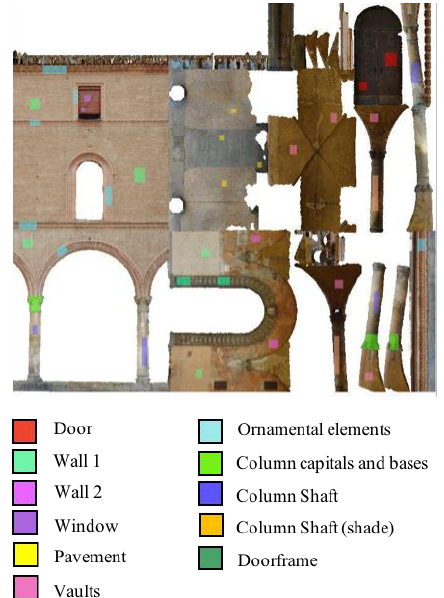
Figure 9: Manual training classes to segment the building for semantic purposes.